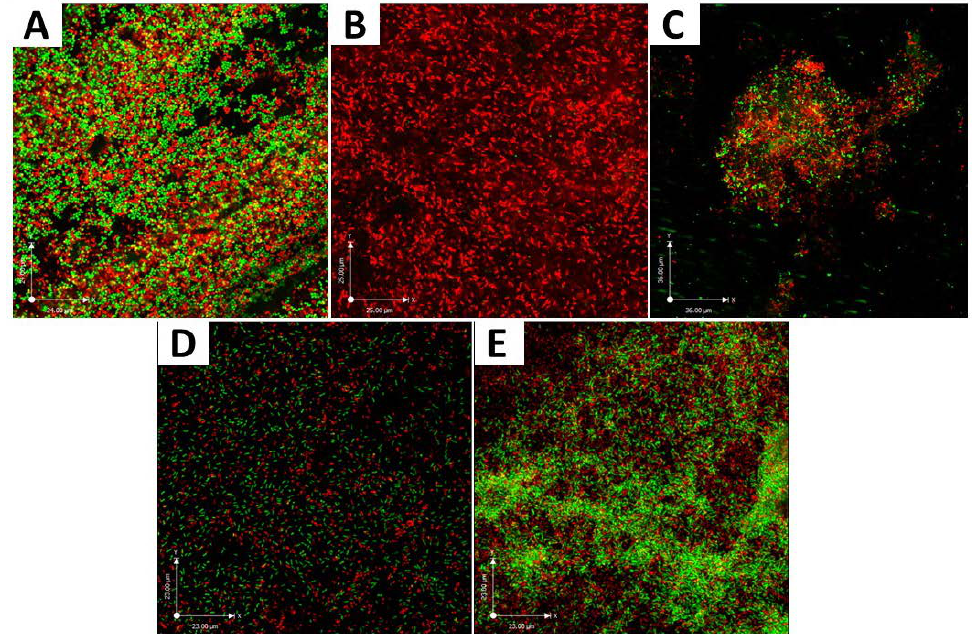
Figure 4. CLSM images of 7-day P. gingivalis biofilm on the dentin surface after application of different concentrations of ε -polylysine. Live bacterial cells are stained green (SYTO 9) and dead bacterial cells are stained red (propidium iodide). ( A ) control; ( B ) 0.125% ε -PL; ( C ) 0.25% ε -PL; ( D ) 0.5% ε -PL; ( E ) 1% ε -PL.